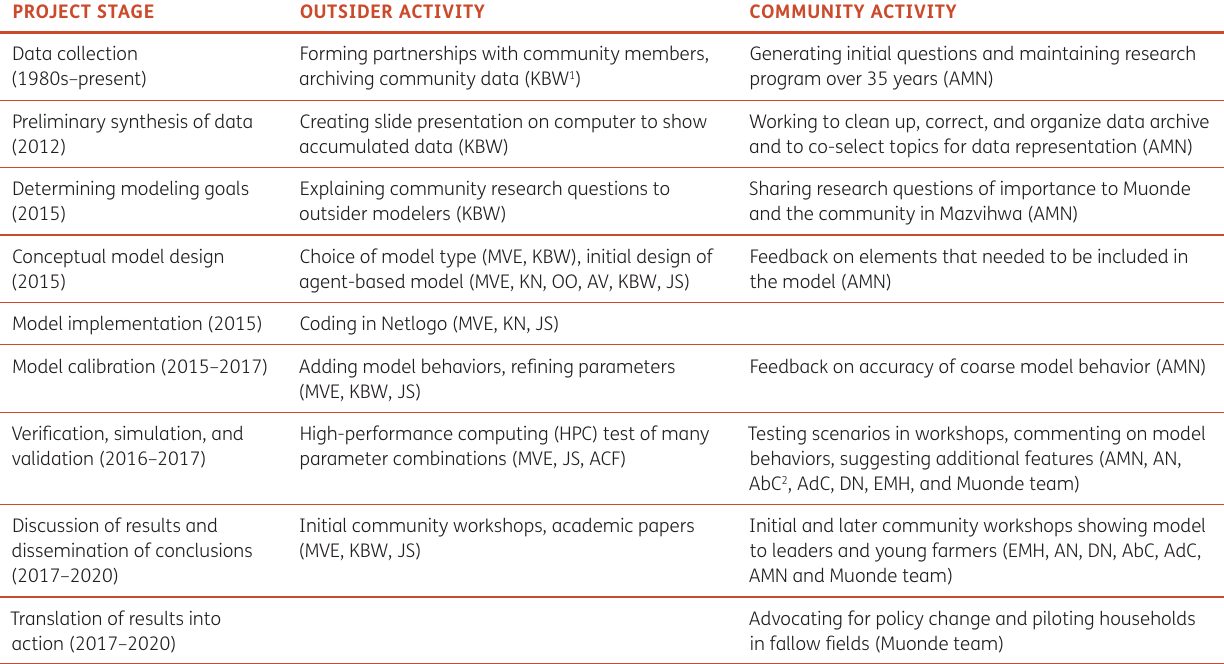
Table 1 Participatory modeling processes; authors’ involvement is indicated by their initials (see Supplemental File 1: Appendix A and Supplemental File 2: Appendix B for a detailed accounting of activities and participants in each activity).